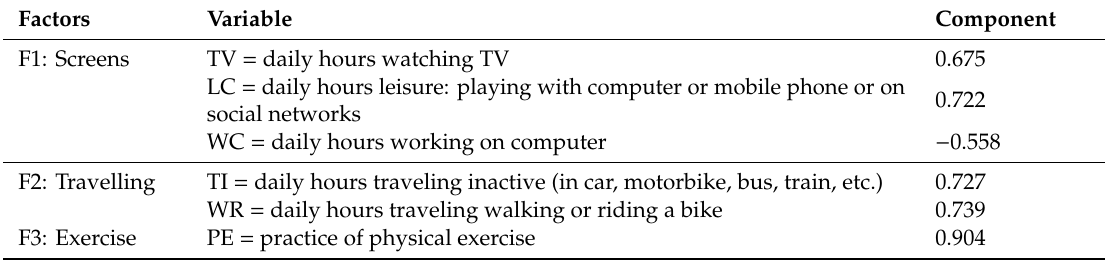
Component matrix obtained by factor analysis to variables related with active or sedentary